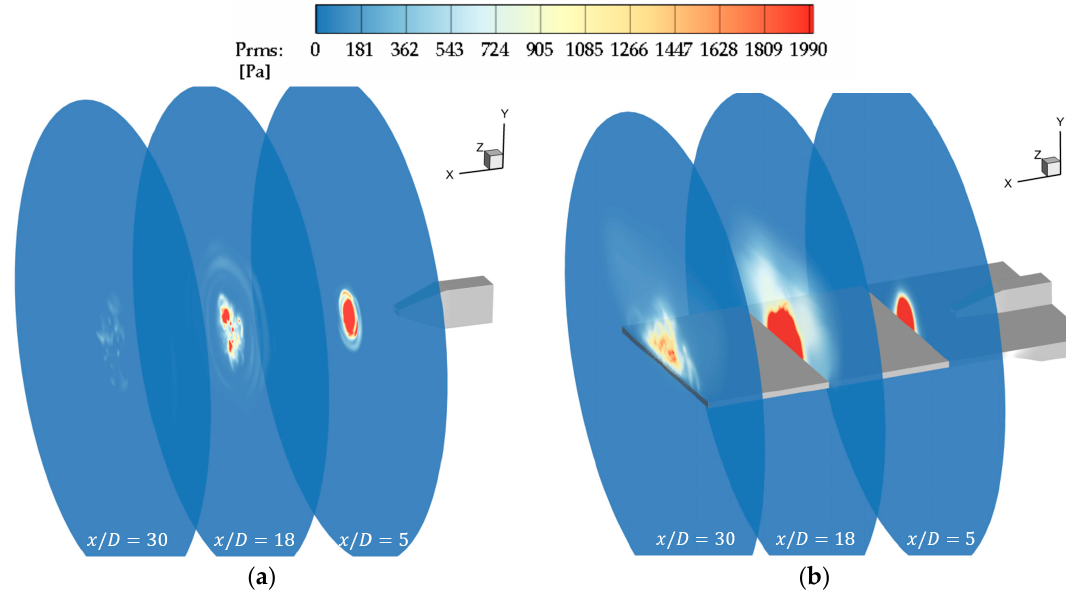
Figure 31. Evolution of the fluctuating pressure R.M.S along jet axis. ( a ) Baseline (BSL) case, ( b ) Shielded case.